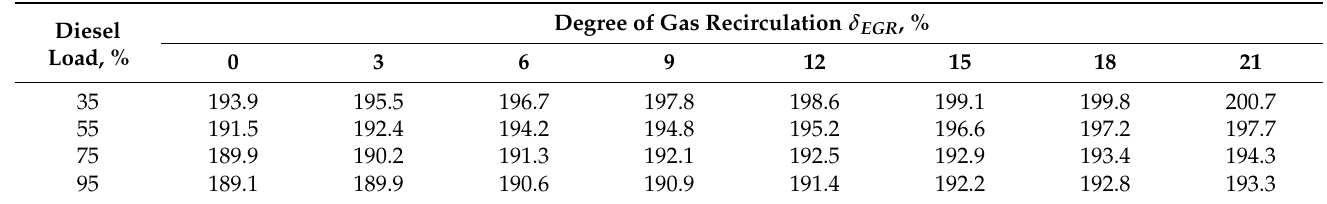
Table 2. Specific effective fuel consumption b e , g/(kWh) marine diesel 16V32 STX-MAN under various loads and degrees recirculation δ EGR